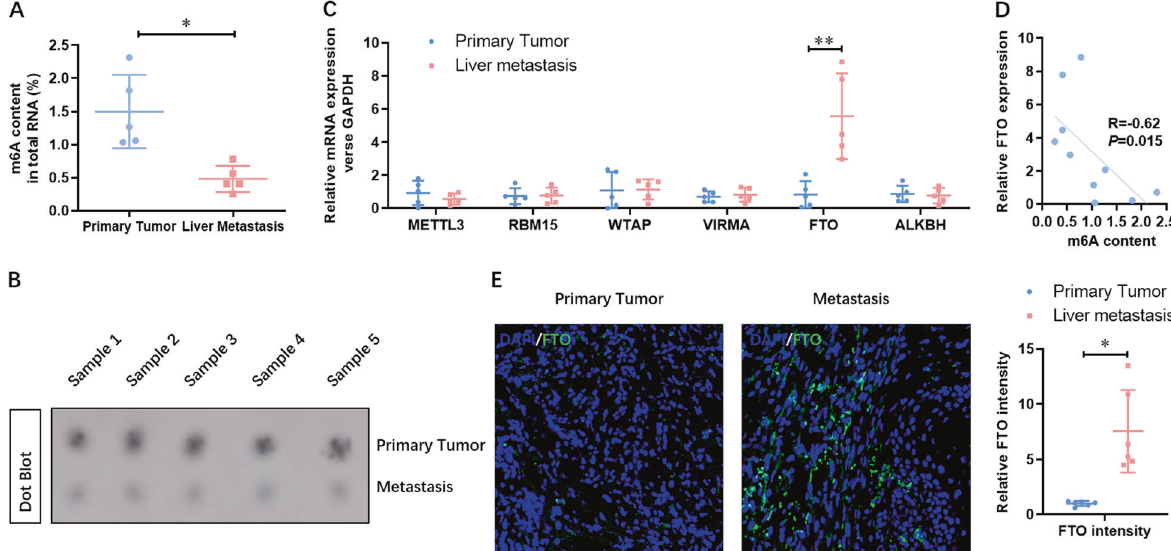
Fig. 2 Down-regulated m 6 A and elevated level of FTO are shown in GC liver metastasis tissues. A The level of m 6 A methylated RNA in the tumor and liver metastasis tumor was analyzed by Colorimetric kit. B The level of m 6 A methylated RNA in the tumor and liver metastasis tumor was con fi rmed by m 6 A Dot blotting analysis. C The expression of FTO at the mRNA level was analyzed by qRT-PCR. D The level of m 6 A was negatively relative with FTO mRNA expression in the tumor and liver metastasis tumor. E The expression of FTO at the protein level was analyzed by IF. N = 5, * p < 0.05, ** p < 0.01 compared with the indicated group.